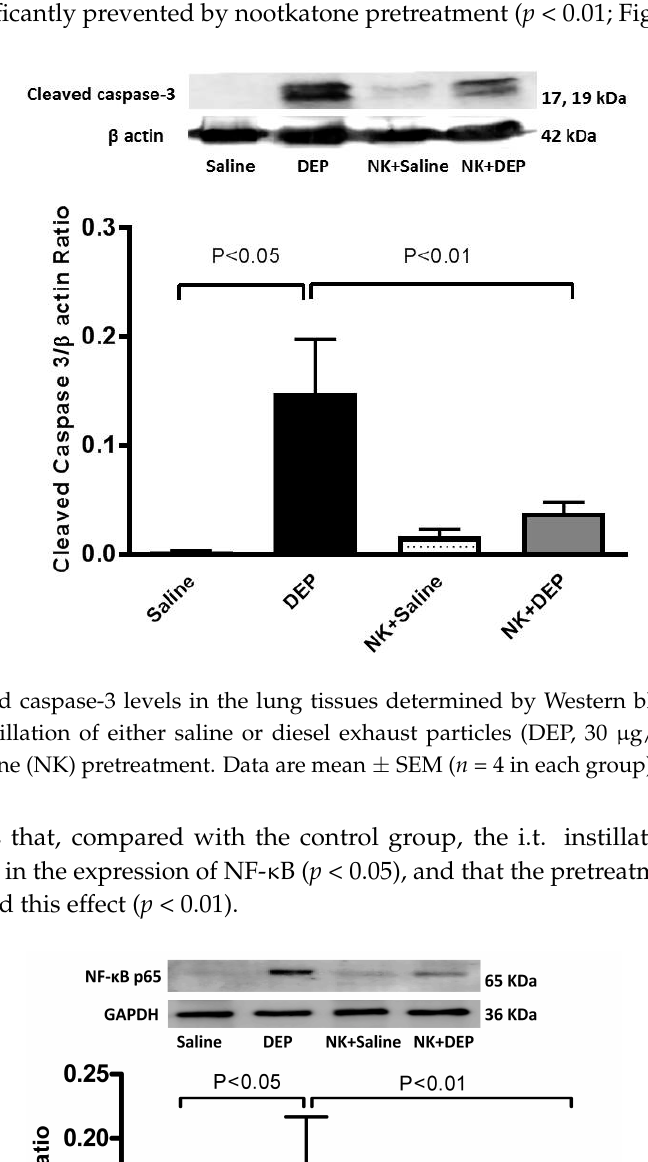
Figure 5. DNA migration (mm) in the lung tissues ( A ) evaluated by Comet assay, 24 h after intratracheal instillation of either saline or diesel exhaust particles (DEP, 30 µg/animal), with or without nootkatone (NK) pretreatment. Data are mean ± SEM ( n = 5 in each group). Representative images, illustrating the quantification of the DNA migration by the Comet assay, under alkaline conditions, in control ( B ); DEP ( C ); NK+saline ( D ) and NK+DEP ( E ).